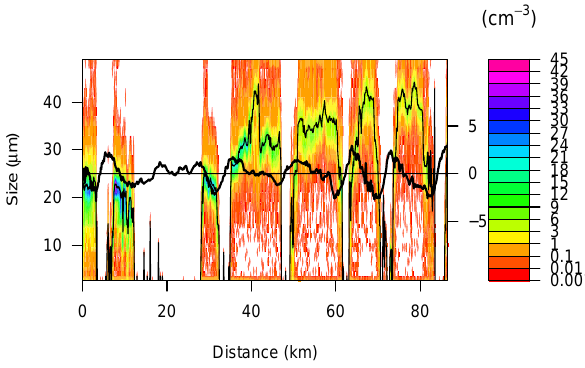
Fig. 5. Size distribution function (filled contour) obtained from CDP data for Run 1, vertical velocity (thick black curve) and the mean volume diameter (thin black